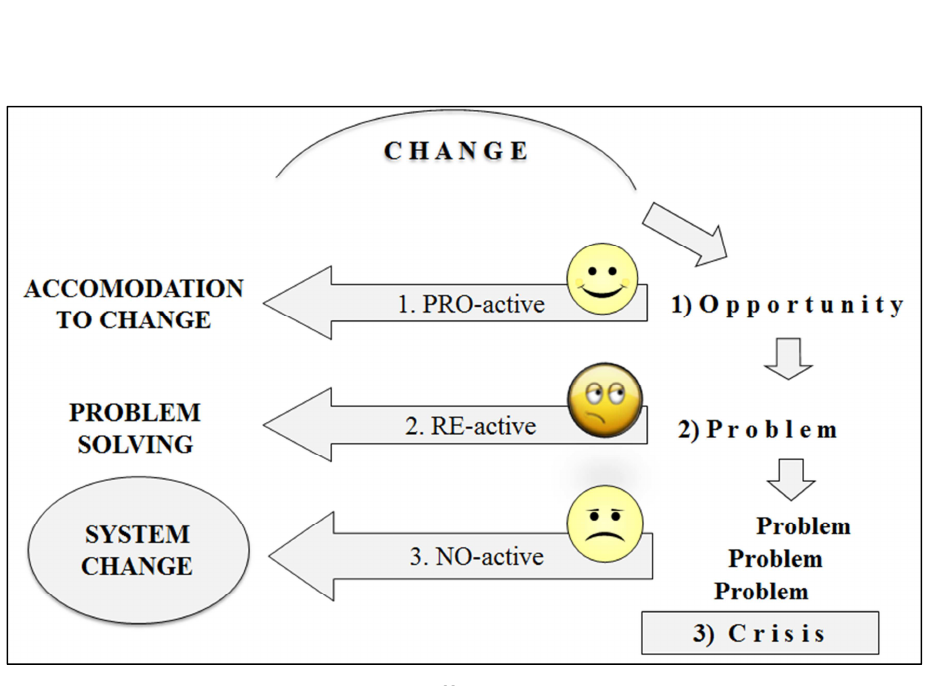
Diagram 4 – Three different reactions on